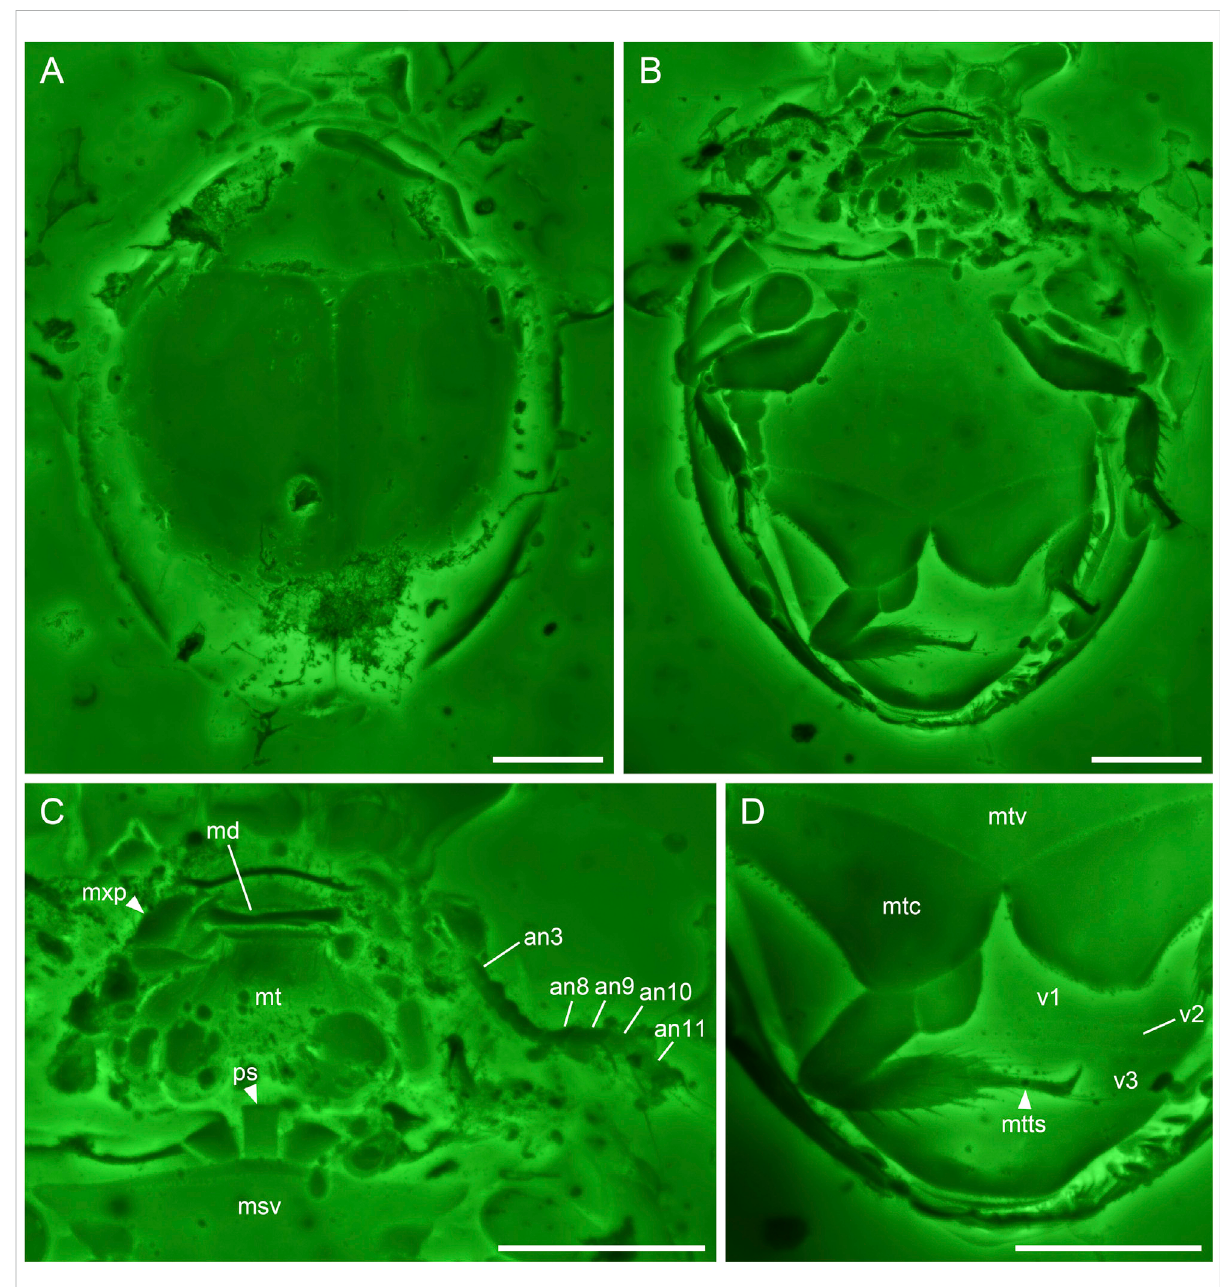
FIGURE 2 Sphaerius martini Li & Cai sp. nov., holotype, NIGP178177, under confocal microscopy. (A) Habitus, dorsal view. (B) Habitus, ventral view. (C) Head and prothorax, ventral view. (D) Hind leg and abdomen, ventral view. Abbreviations: an3 – 11, antennomeres 3 – 11; md, mandible; msv, mesoventrite;mt,mentum;mtc,metacoxa;mtts,metatarsus;mtv,metaventrite;mxp,maxillarypalp;ps,prosternum;v1 – 3,ventrites1 – 3.Scalebars: 100 μ